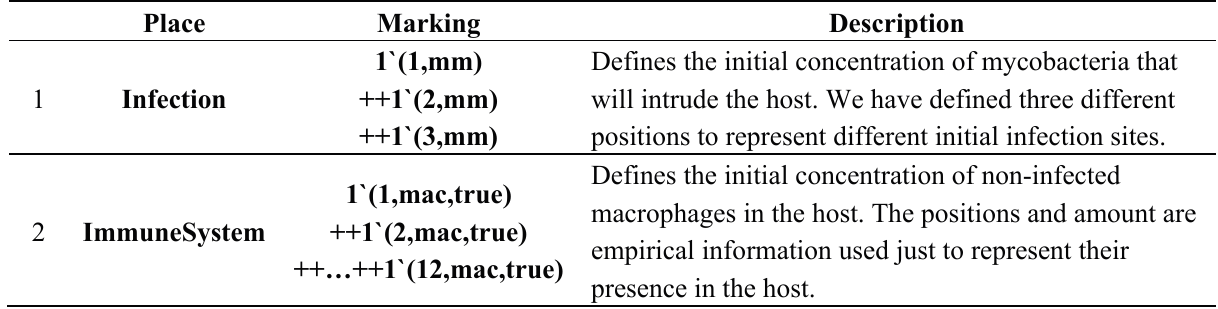
Table 6. Example markings initially defined in the colored Petri net